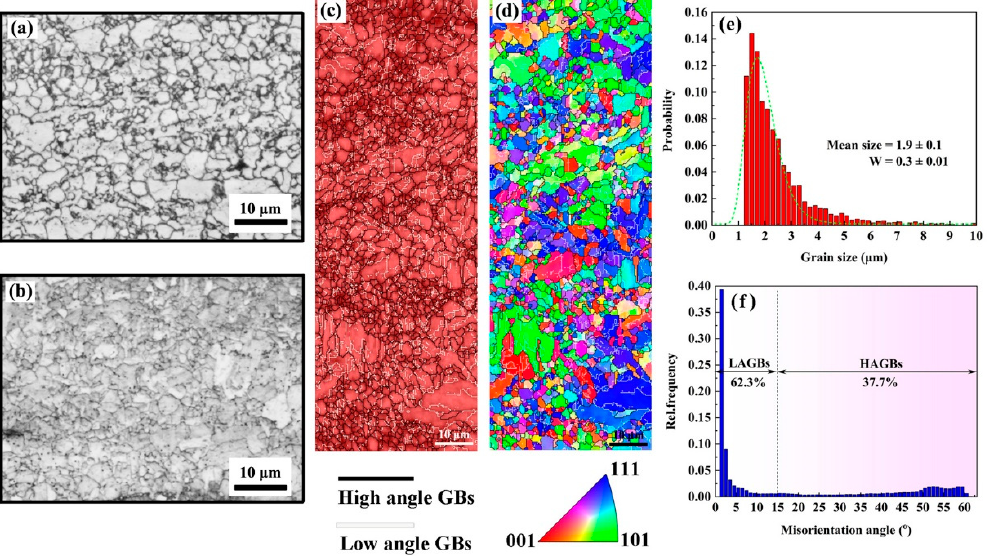
Figure 2. The metallograph of ( a ) SS steel and ( b ) AG2h steel; ( c ) phase map with high and low angle grain boundaries (GBs); and ( d ) inverse pole figure (IPF) map of the SS steel together with ( e ) its grain size and ( f ) grain boundary distributions.